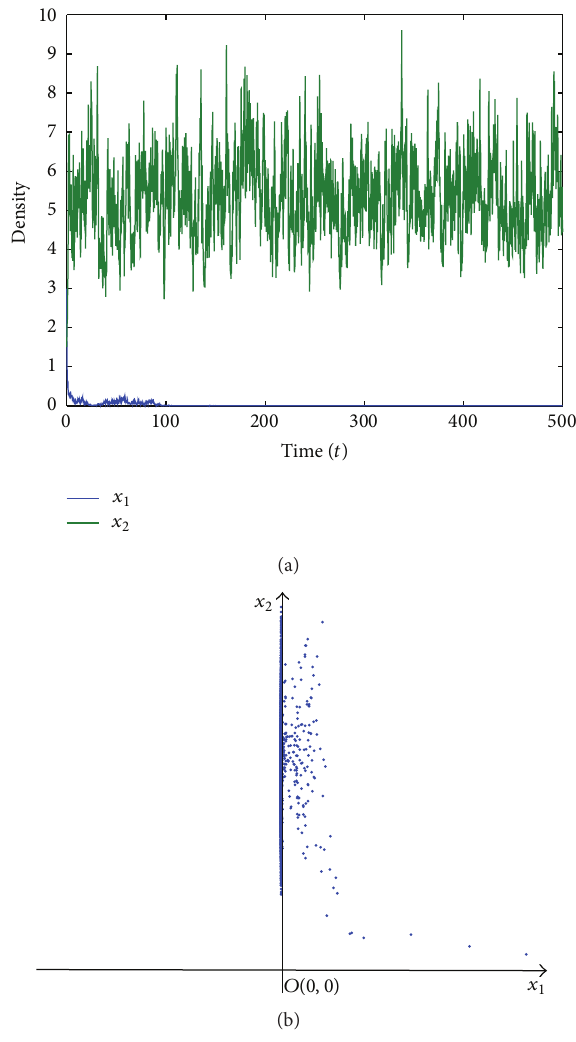
Figure 1: Numerical simulations of Example 8 (there is no diffu- sion). Species in the 1st patch has a Dirac delta distribution with mass concentrated in 0, and species in the 2nd patch has a stationary